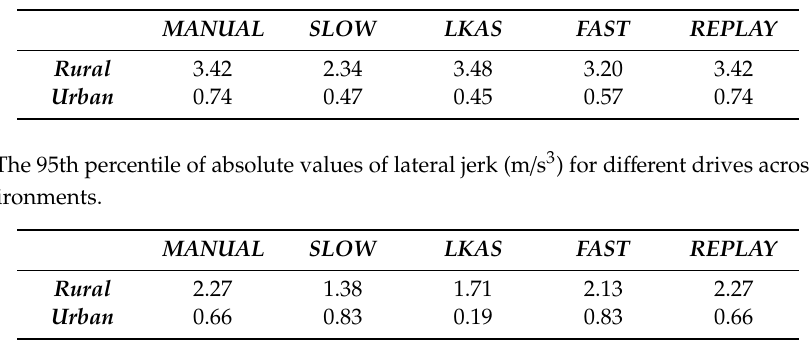
Table 2. The 95th percentile of resultant acceleration (in m / s 2 ) for di ff erent drives across di ff erent road environments.